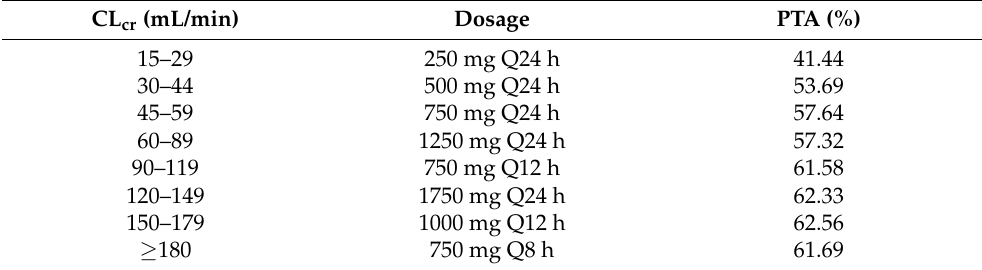
Table 3. Recommended initial dosage regimens for targeted AUC 24 between 400 and 650 mg · h/L. CL cr